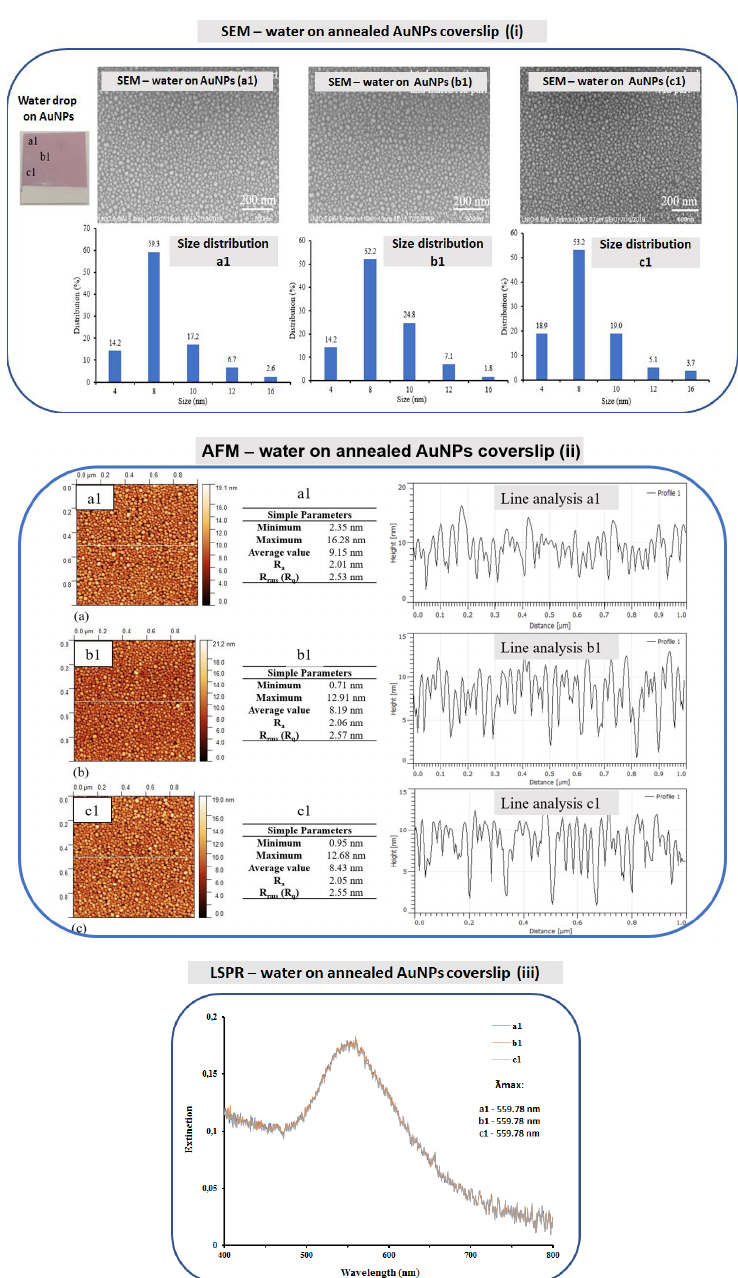
Figure 4. SEM ( i ), AFM ( ii ) and LSPR ( iii ) characterizations of annealed gold nanostructured (AuNPs) coverslips exposed to water drops, air dried and with three investigated areas: a1 (under the drop), b1 (in the vicinity of the drop) and c1 (far from the drop). The size distribution of AuNPs (based on SEM image) and line profile analysis (based on AFM images) were acquired for a1, b1 and c1 (dd-water, pH = 7.0). The SEM, AFM and LSPR measurements were performed under cleanroom conditions at 21 ◦